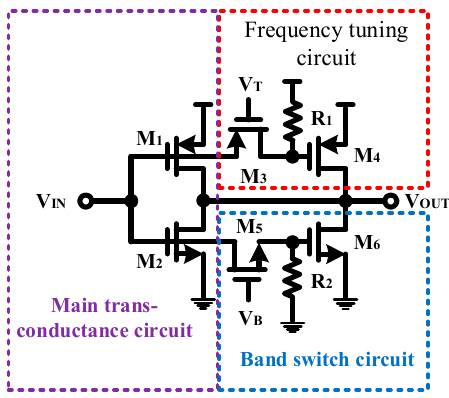
Figure 2. Proposed dual-band six-phase voltage-control oscillator.